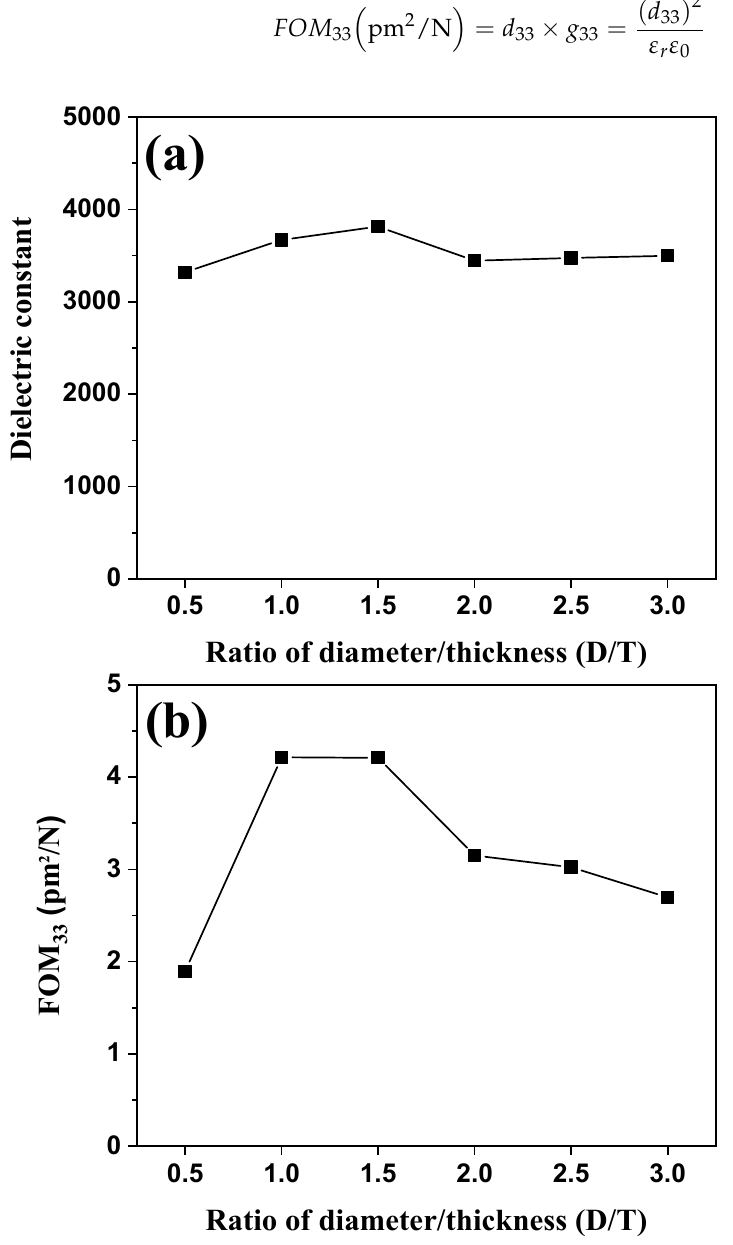
Figure 7. ( a ) Dielectric constant and ( b ) FOM 33 of BZT–BCT ceramics vs. the D/T ratio.